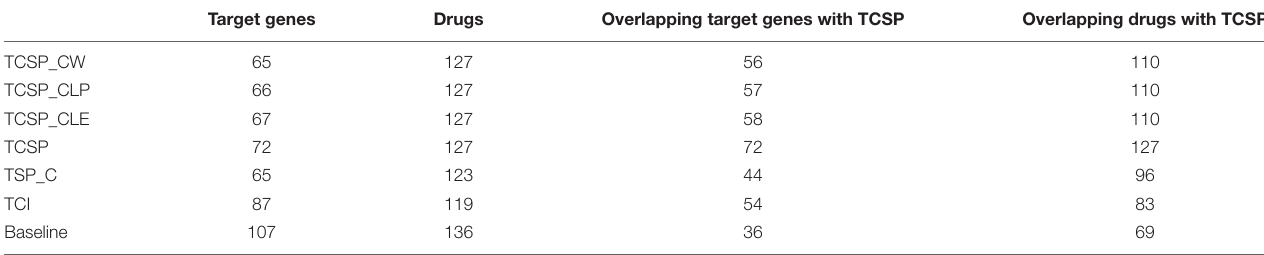
TABLE 2 | The top 200 drug target genes in the ranking list. Target genes Drugs Overlapping target genes with TCSP Overlapping drugs with TCSP